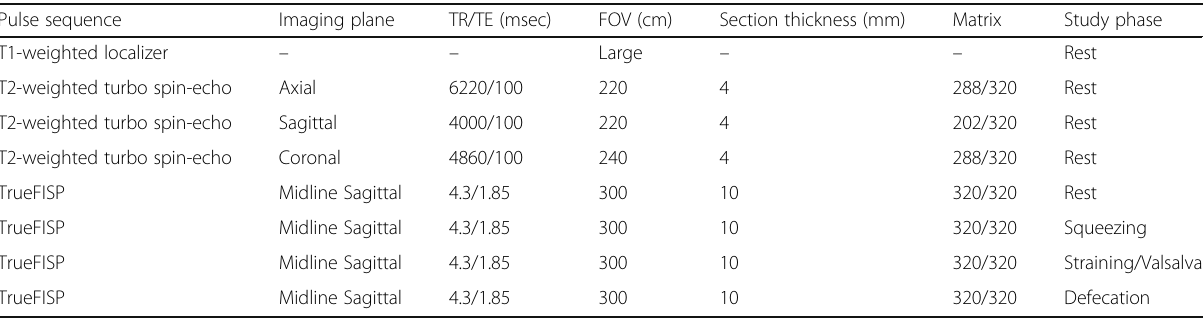
Table 1 MR defecography protocol. FOV, field of view; TE, echo time; TR, repetition time Pulse